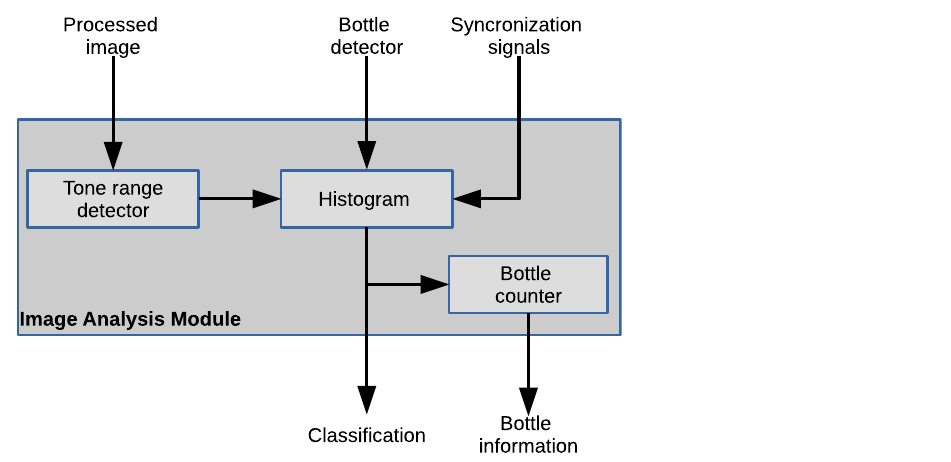
Figure 5. Block diagram of the analysis